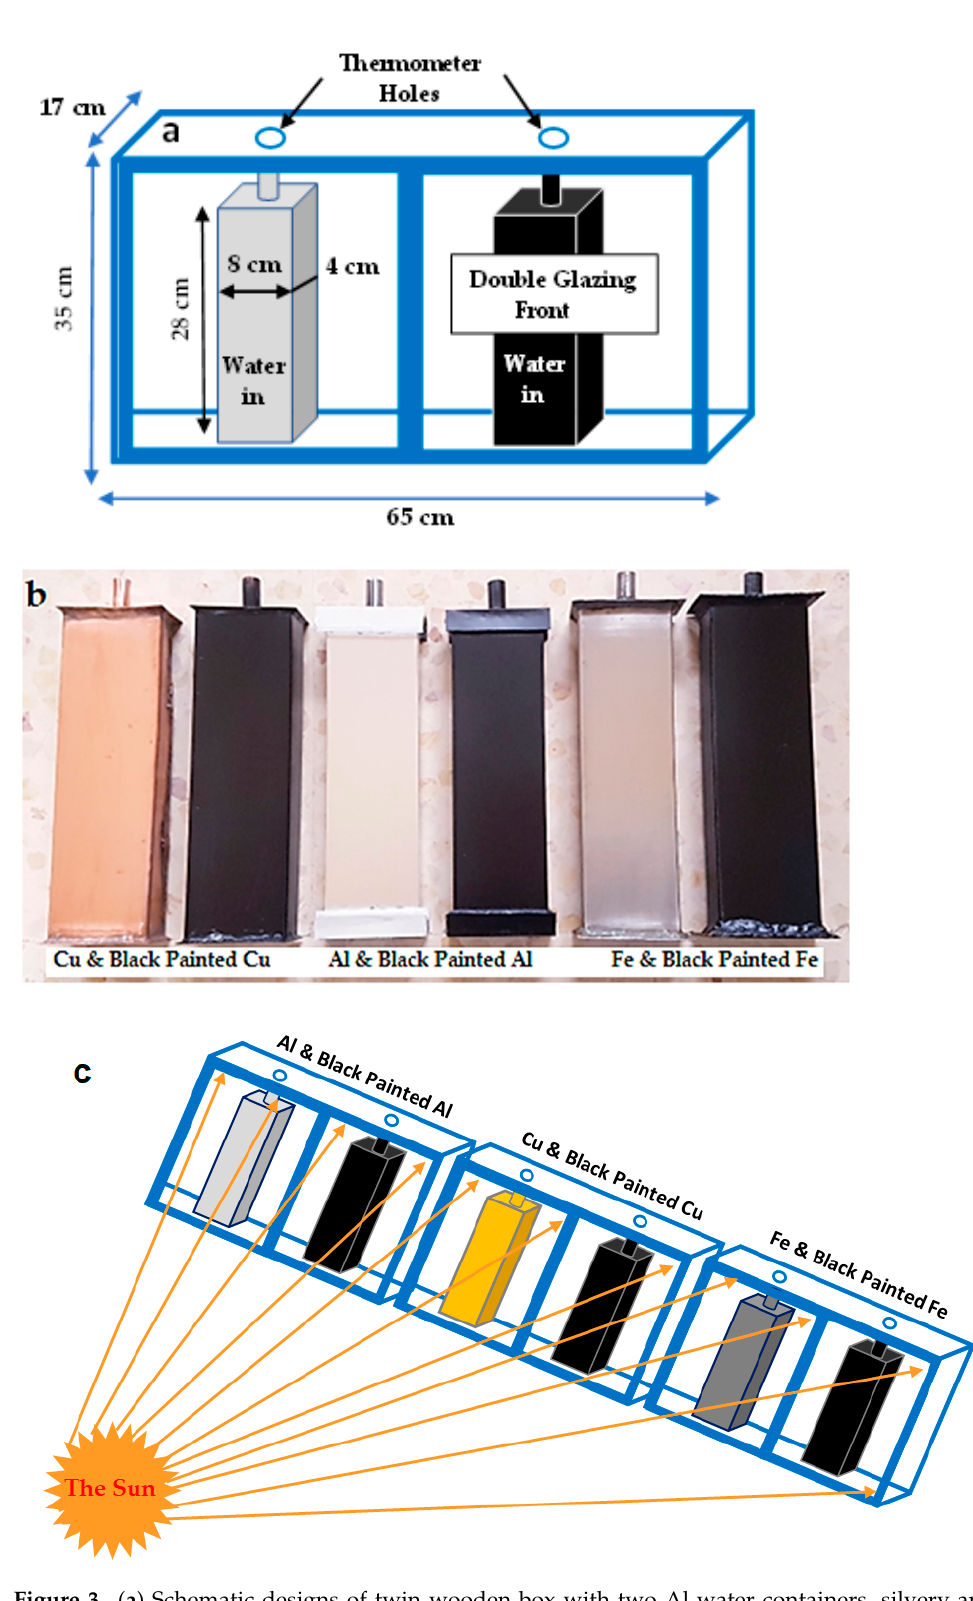
Figure 3. ( a ) Schematic designs of twin wooden box with two Al water containers, silvery and black. ( b ) Three twin containers of Cu, Al, and Fe of around 1 mm thickness, bare and matte-black-painted. ( c ) Schematic design of three wooden boxes with six water containers inserted, showing the simultaneous exposure of all boxes to the Sun for a given experiment.